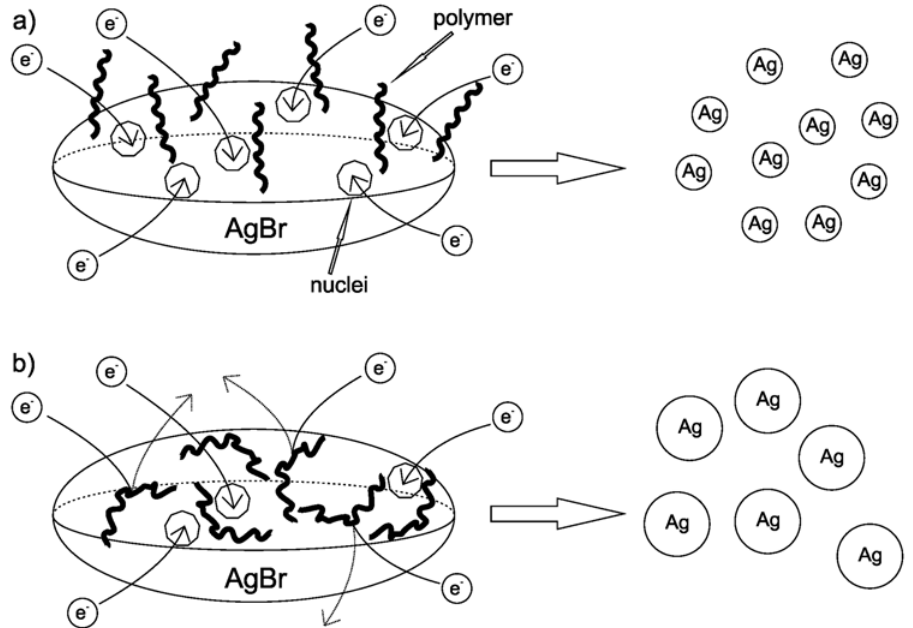
Fig 5. Schematic illustration of nucleation and formation process of Ag NPs from AgBr NPs affected by a) PEG or HEC and b) PVP or PVA.